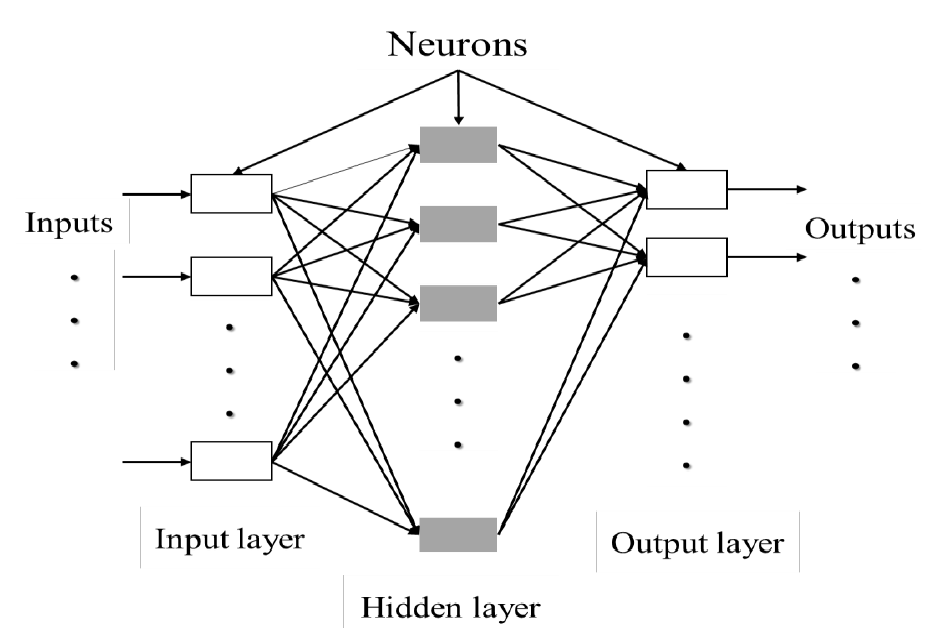
Figure 4. Architecture of a multilayered structure of artificial neural network. Adapted from Abraham [142].